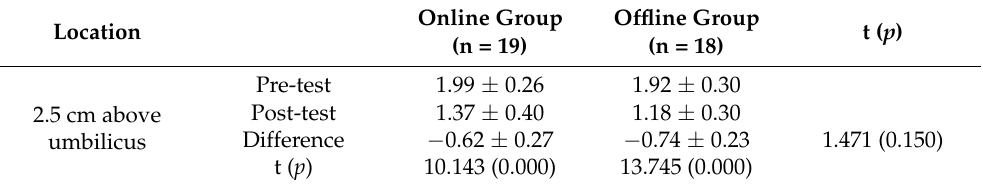
Table 2. Inter-recti distance (mm) (N = 37).